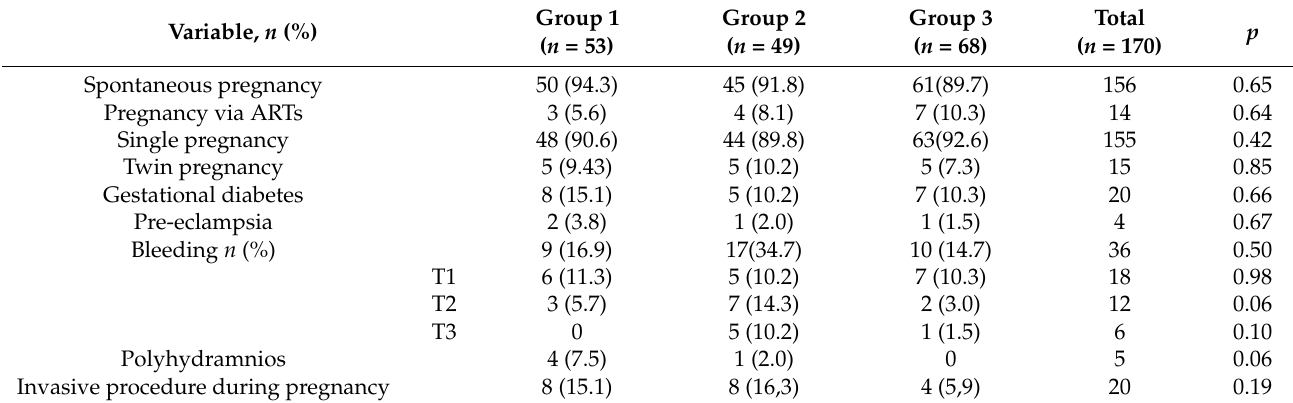
Table 2. Characteristics of pregnancy and intercurrent events.